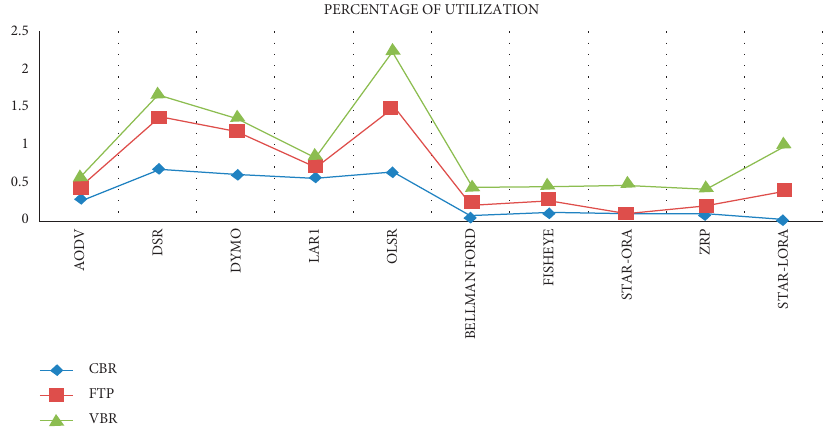
Figure 18: Percentage of utilisation of all routing protocols for 60 nodes.